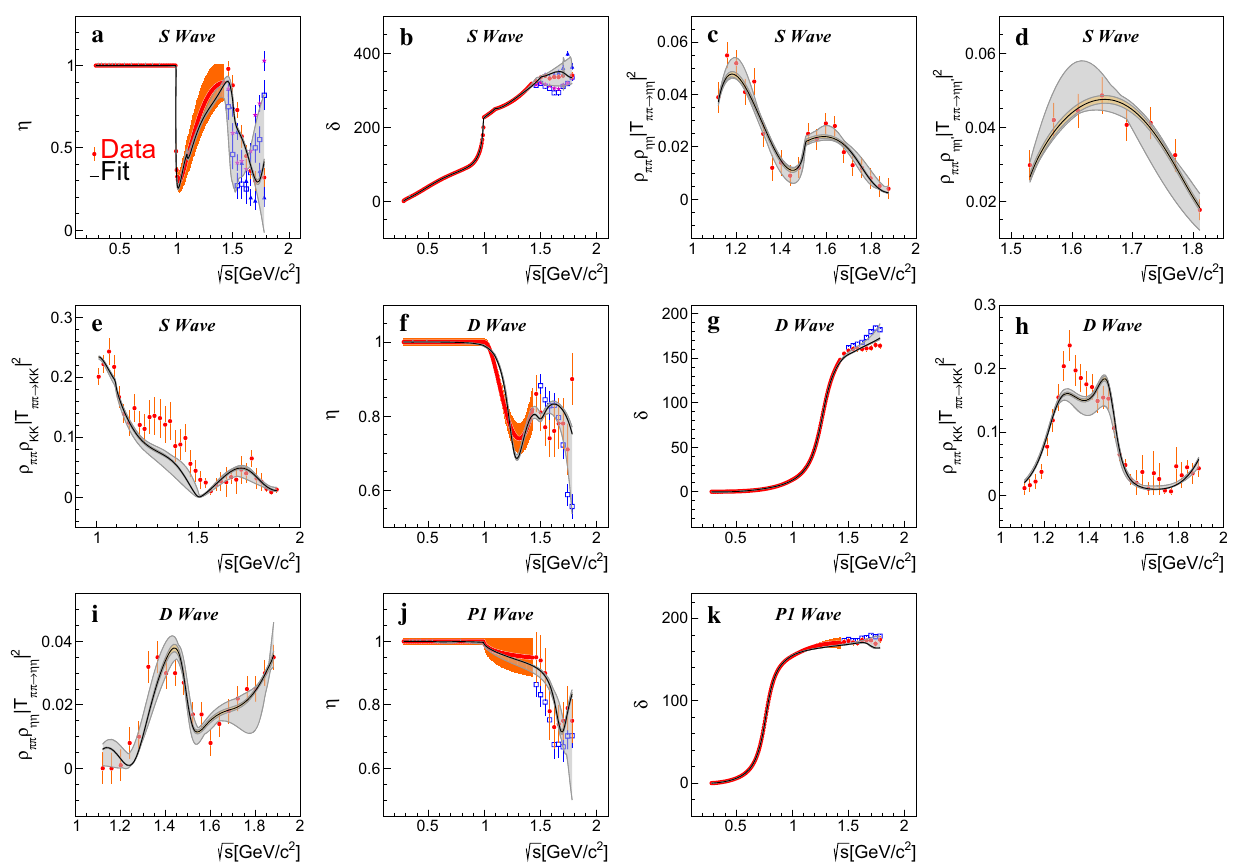
Fig. 11 Results for scattering data. a , b for S wave ππ → ππ inelasticity and phase shift, c – e for | T | 2 -values of processes ππ → ηη,ηη (cid:8) , K K in S wave. f , g for D wave ππ → ππ inelasticity and phase shift. h , i for | T | 2 -values of processes ππ → K K ,ηη , j , k for P1 wave ππ → ππ inelasticity and phase shift. The data considered in the best fit are given by red points with error bars which includes the solution ( − − − ) from [21] ( a , b ), and solution ( − − − ) from [22] ( f , g , j , k ). Data sets from multiple solutions are taken into account as